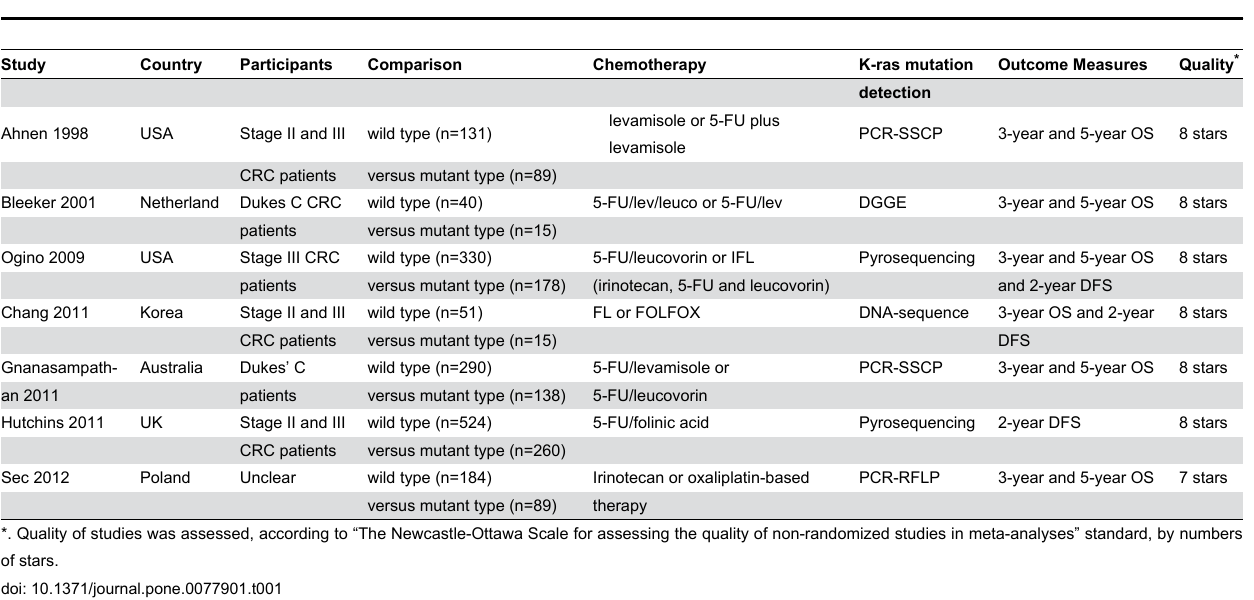
Table 1. General Information of Included Studies.